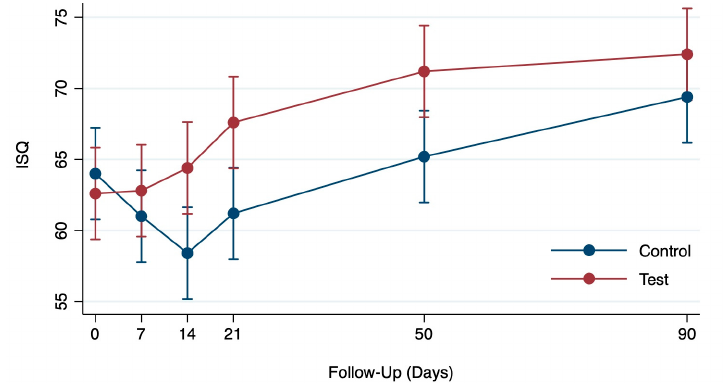
Figure 2. ISQ mean values and standard deviation (vertical bars) of the control (G1) and the test (G2) group. Measurements were recorded during the follow-up visits at different time points: T0 (immediately after the implant placement), T7 (7th day after implant placement), T14 (14th day after implant placement), T21 (21st day after implant placement), T50 (50th day after implant placement), and T90 (90th day after implant placement).